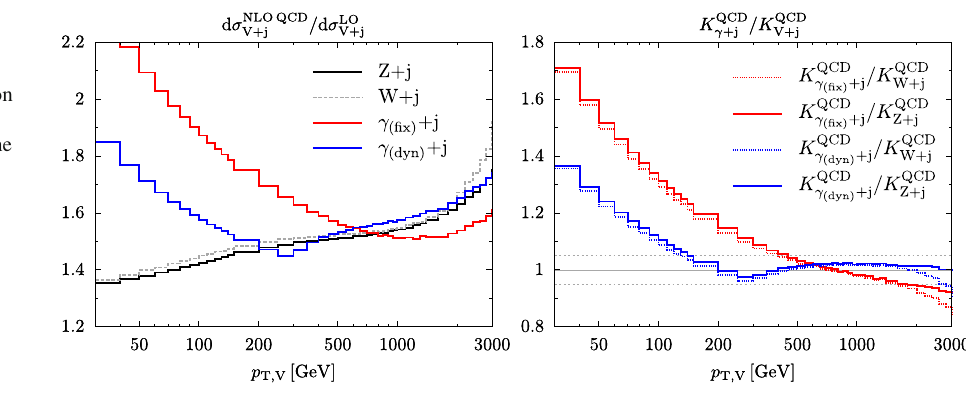
Fig. 2 Comparison of NLO QCD K -factors (left) for W + jet, Z + jet, and γ + jet production with dynamic photon isolation (13) and standard fixed-cone isolation (14). On the right corresponding ratios of K -factors are shown, and the dotted lines indicate K -factor variations of ± 0 .